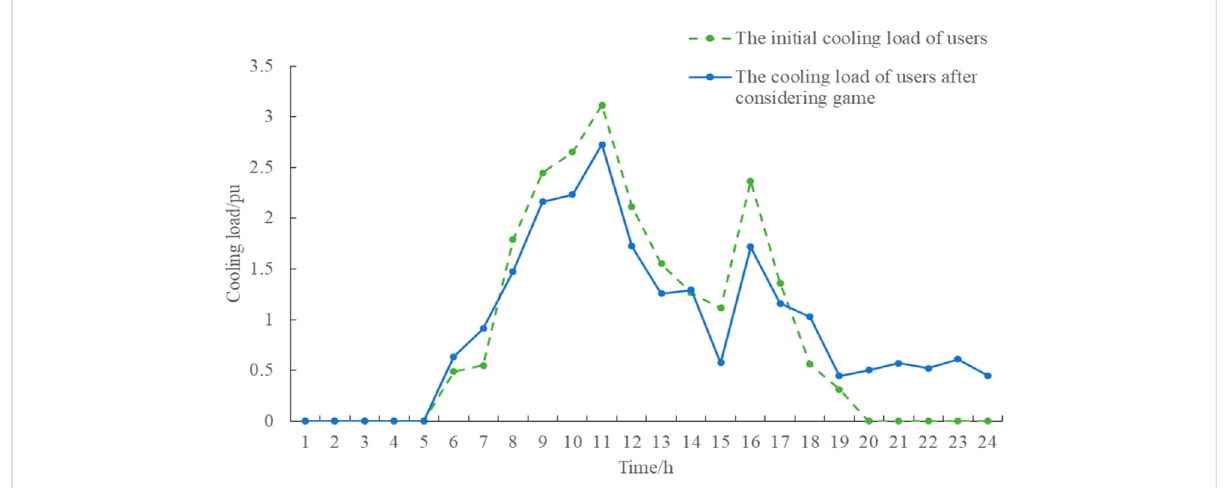
FIGURE 8 Comparison between users ’ initial cooling load and cooling load after considering the